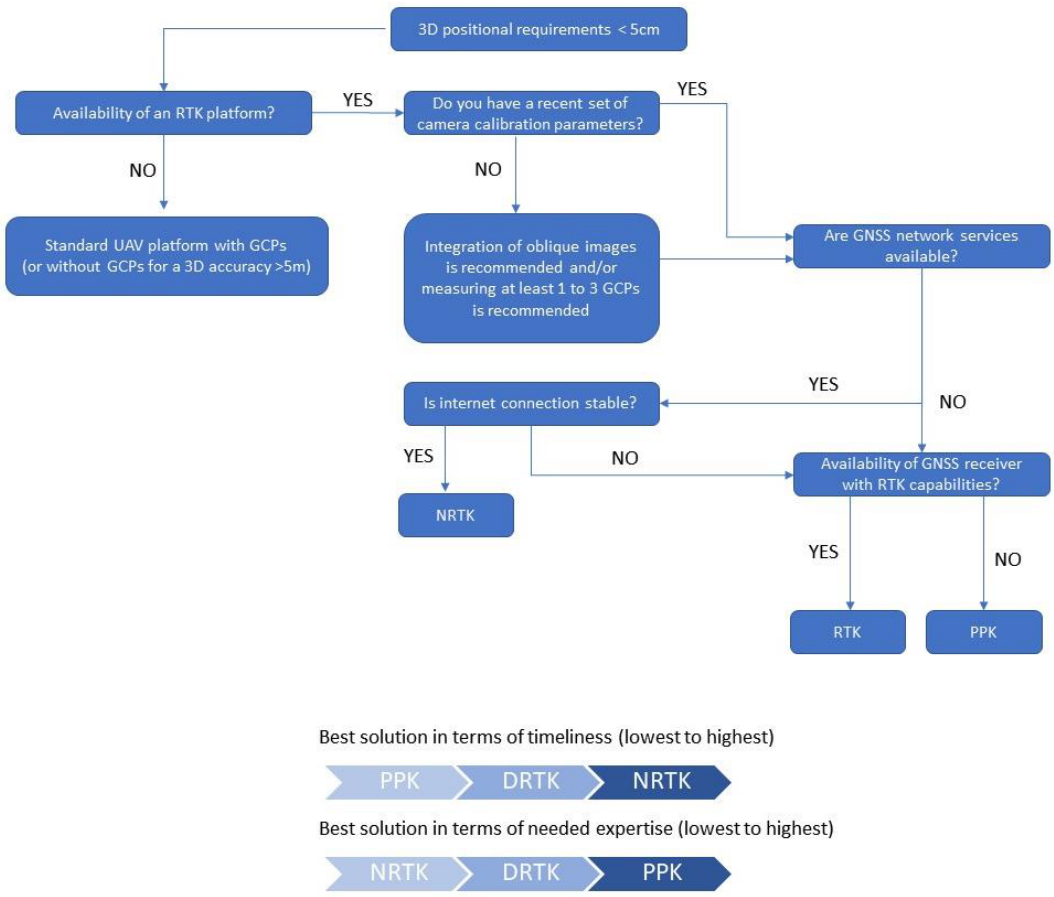
Figure 8. Flowchart summarizing the best operational approaches depending on the map accuracy requirements and available technological